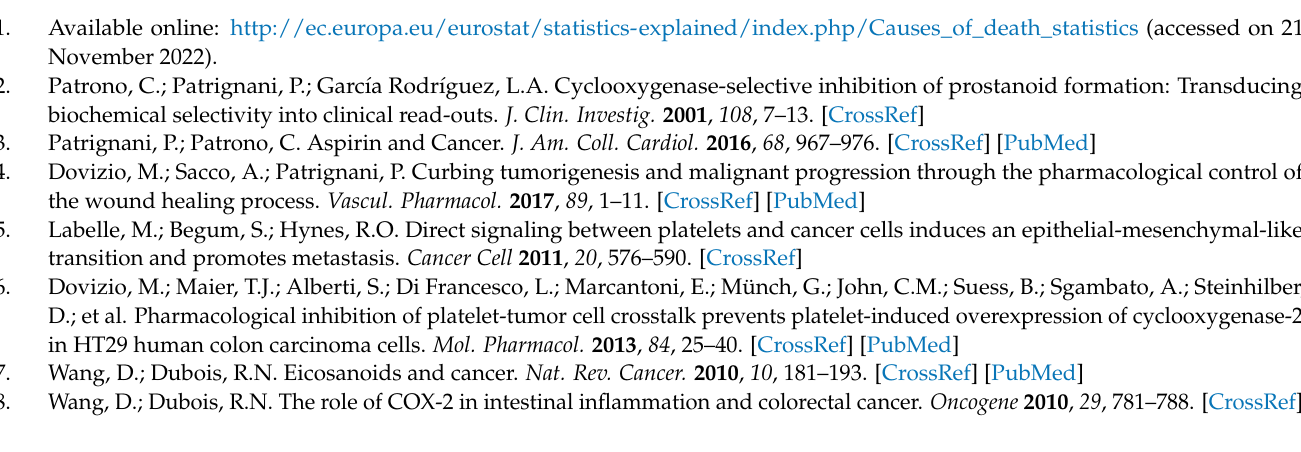
cancer cell lines vs. GAPDH at baseline, by qPCR. Figure S2: Baseline TXB 2 generated by cancer cells at 4 and 24 h of culture. Figure S3: Downregulated pathways in mEVs from CRC patients vs. HS. Figure S4: Upregulated pathways in mEVs from CRC patients vs. HS. Table S1: Name of the different cell lines used in this study, the Duke’s stage, the genetic profile and COX-isozyme expression [63,64]. Table S2: List of identified proteins in platelet-derived mEVs. Table S3. List of modulated proteins in mEVs of CRC patients vs.